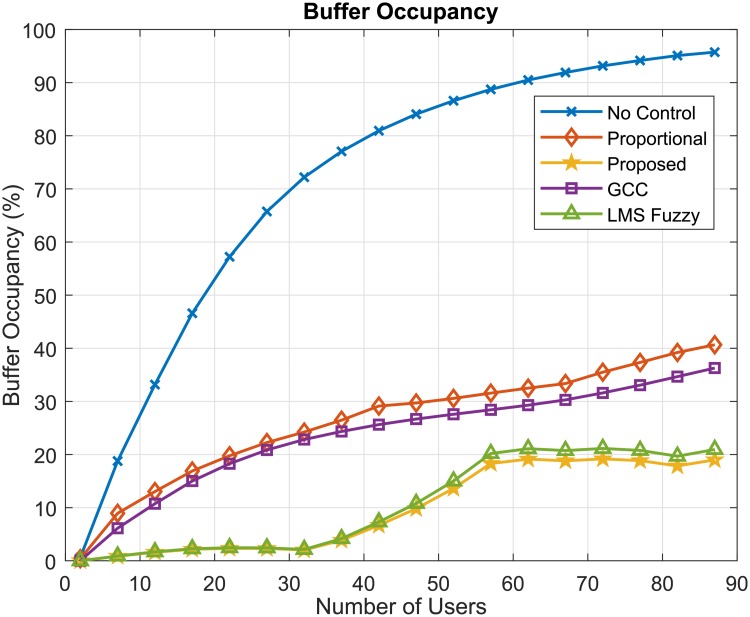
Buffer occupancy (%).